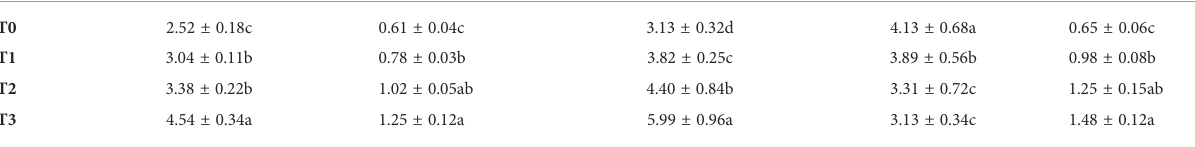
TABLE 3 The main effects of light intensity on chlorophyll a content, chlorophyll b content, total chlorophyll content, chlorophyll a/b and carotenoid content of C. betulus